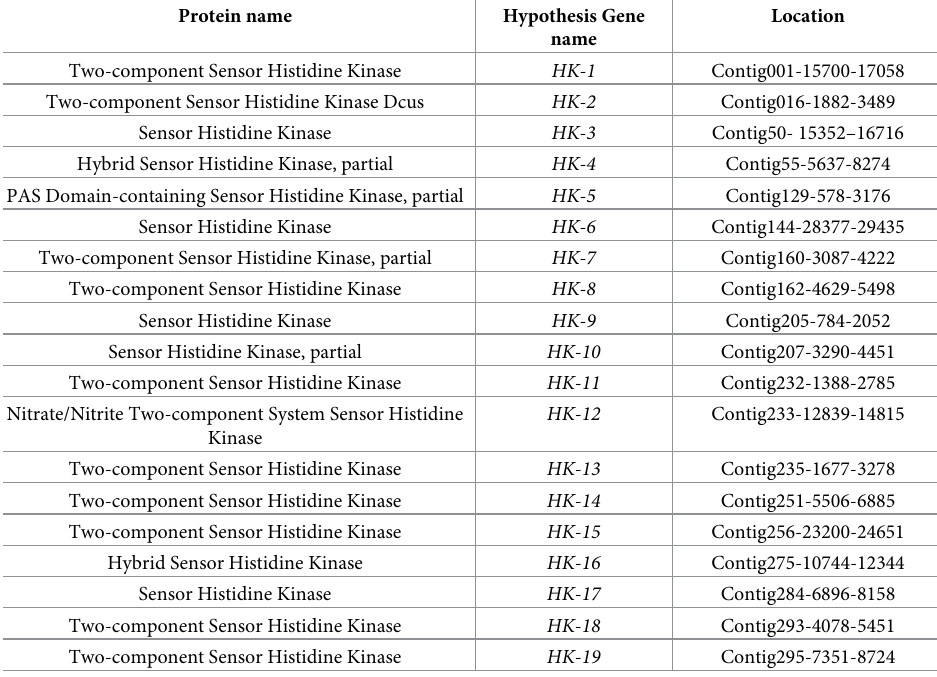
Table 1. Two-component systems of Pseudomonas stutzeri .